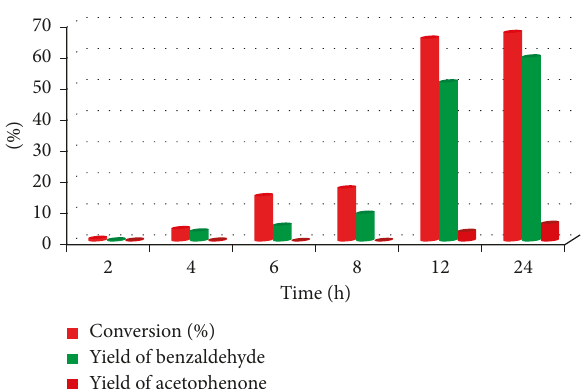
Figure 4: Effect of reaction time on the oxidation of styrene. Reaction conditions: H Yields are determined by GC using dodecane as an internal standard.